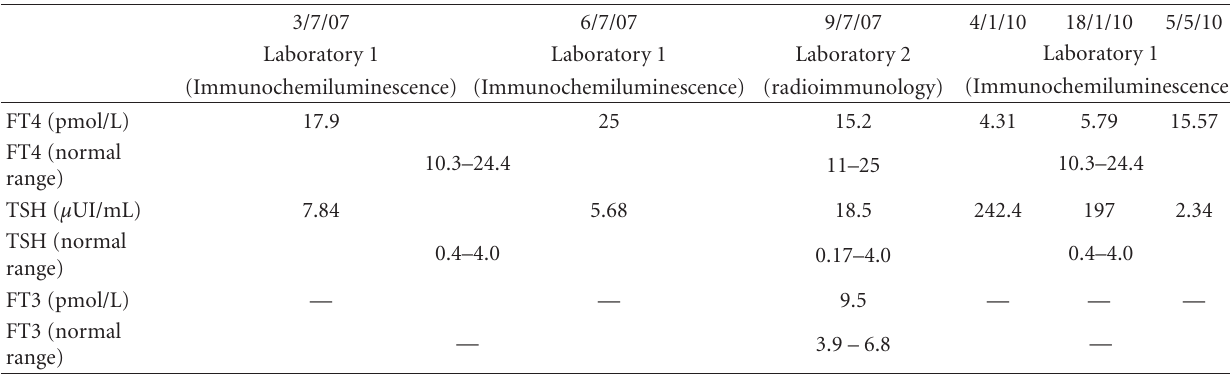
Table 2: Evolution of the biochemical findings of the index